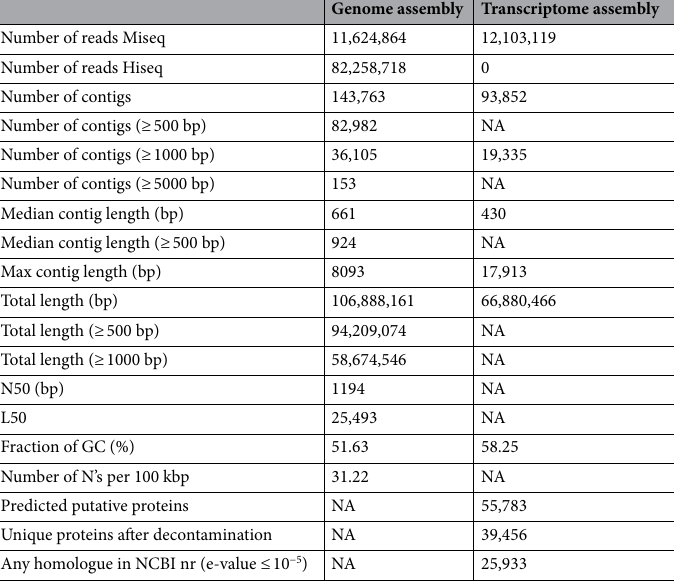
Table 1. Parameters of the genomic and transcriptomic assemblies.